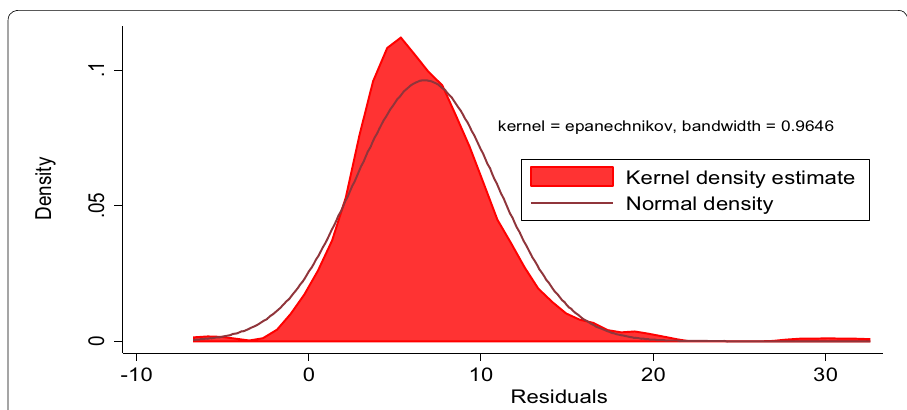
Fig. 6 Kernel density estimate of residuals in multiple linear regression analysis